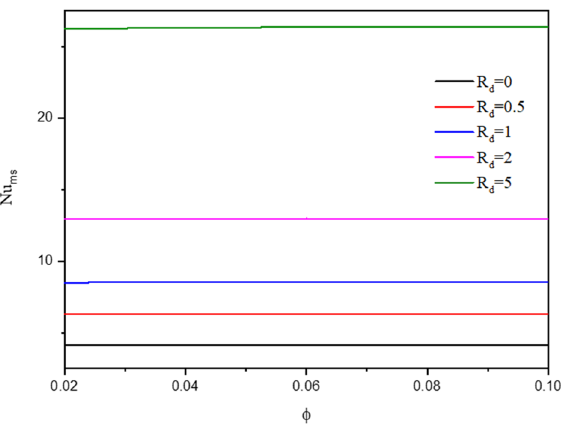
− 3 , Ha = 10, k = 1, D = 0.5, fs